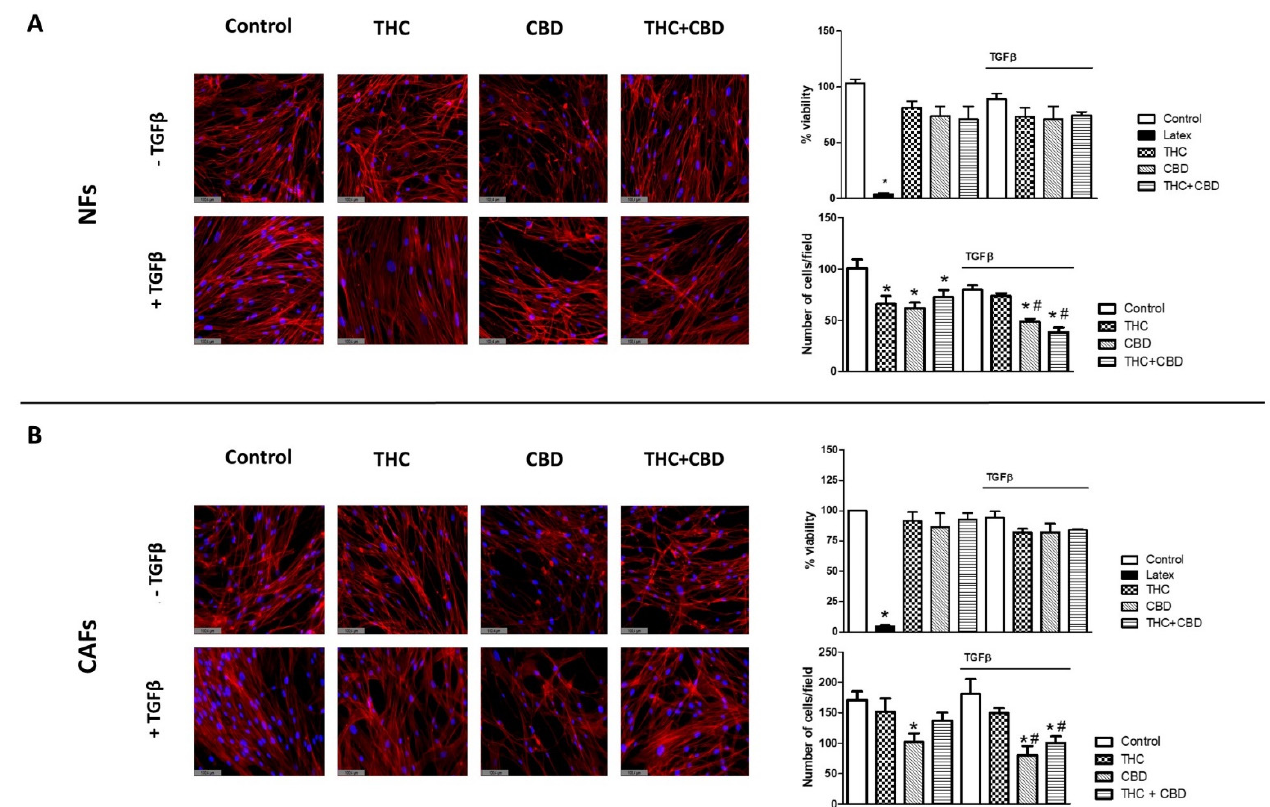
Figure 1. Effect of cannabinoids on cell morphology, viability and cell density in normal fibroblasts (NFs, ( A )) or cancer-associated fibroblasts (CAFs, ( B )). Cells were cultured for 72 h in the presence or absence of 5 ng/mL TGF β and treated or not with 30 µ M THC, 30 µ M CBD, or an equimolar mixture of 10 µ M of THC + CBD. Cellular morphology was studied by fluorescent staining of F-actin microfilaments, using rhodamine-conjugated phalloidin. Representative fluorescence images from to 3 different experiments are shown. The percentage of viability was measured by the MTS assay using latex as a positive control for citotoxicity. Cell density was obtained by counting the number of DAPI-stained cell nuclei in five fields. The mean ± SD of 3 different experiments is represented. A triplicate was analyzed in each of the experiments. * p < 0.05 compared to the control group not stimulated with TGF β . # p < 0.05 compared to the TGF β -stimulated control group. Scale bar is equal to 100.4 µ